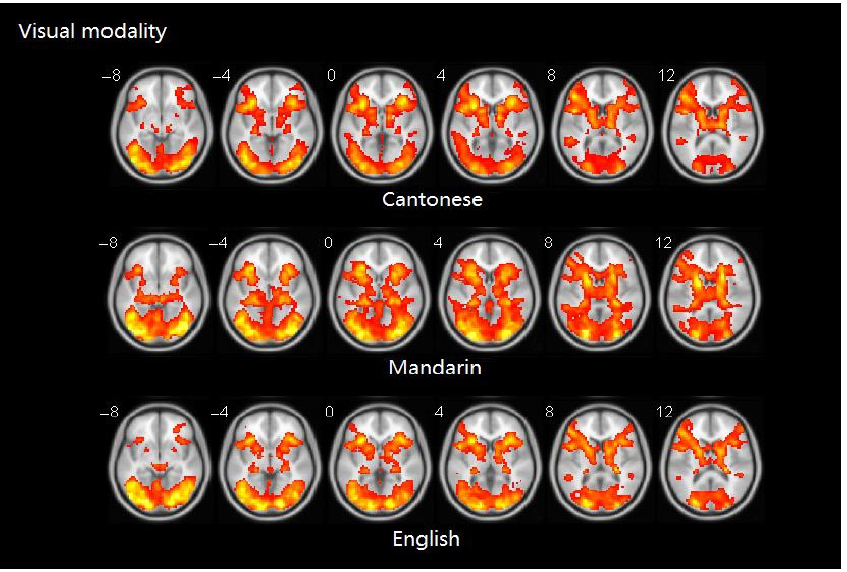
Figure 4. Brain activity maps of Cantonese, Mandarin, and English in visual modality.